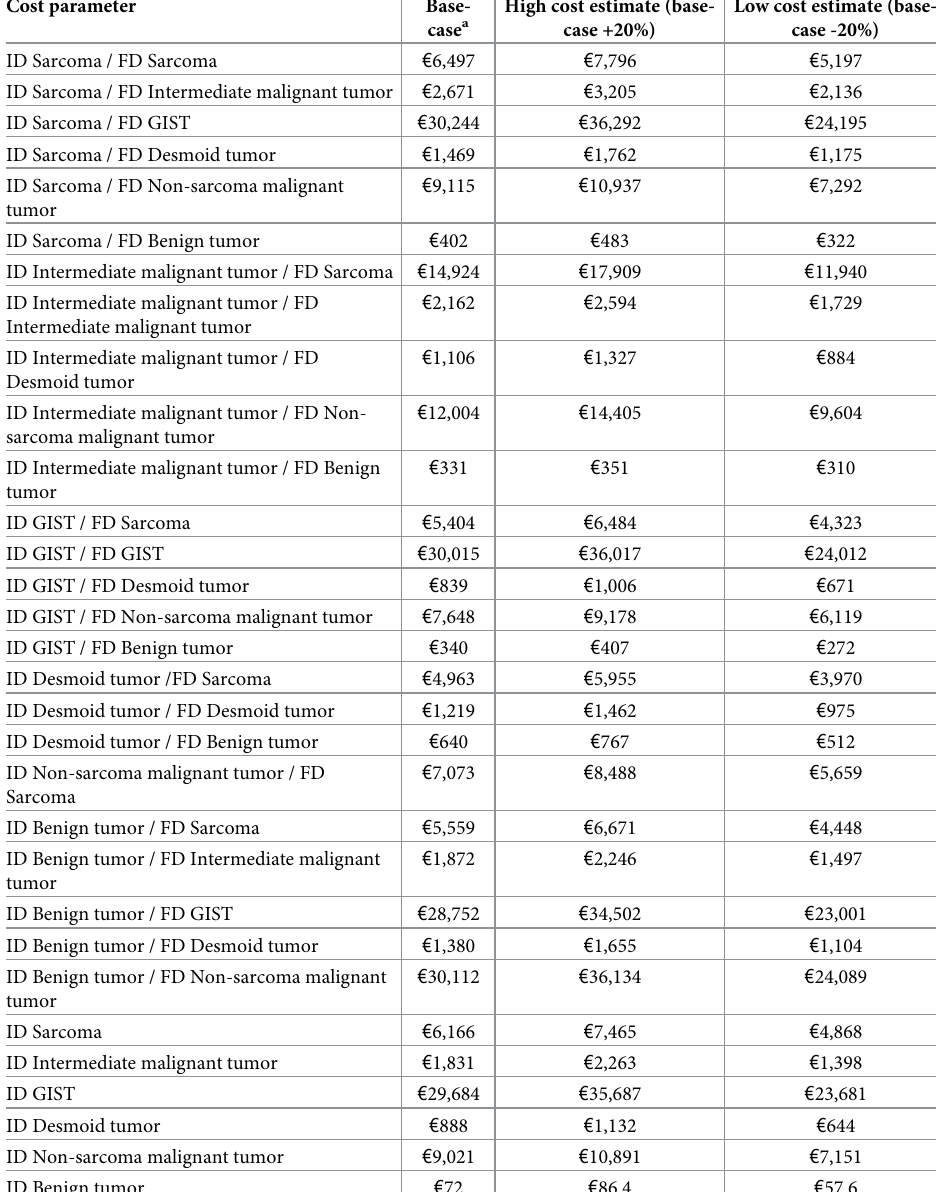
Table 8. Costs parameters of disease management used in the decision-tree model (in € for